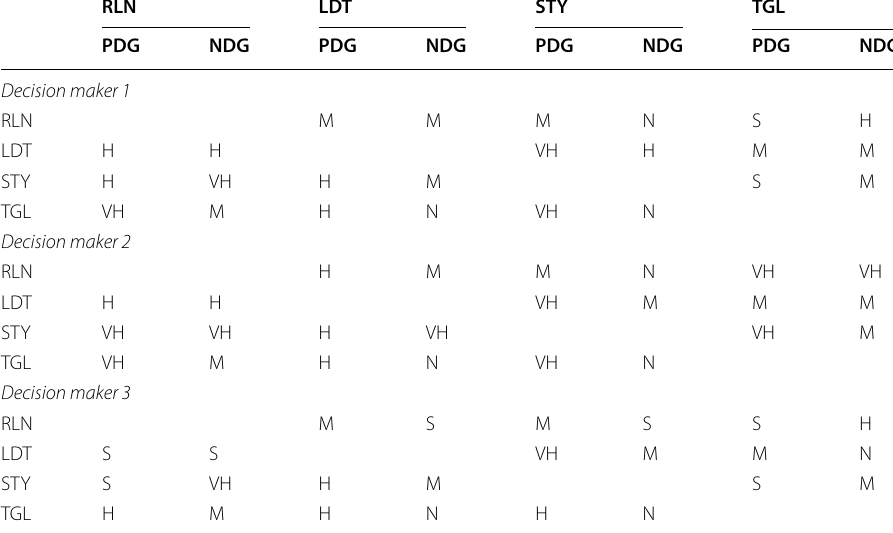
Table 3 Evaluations for